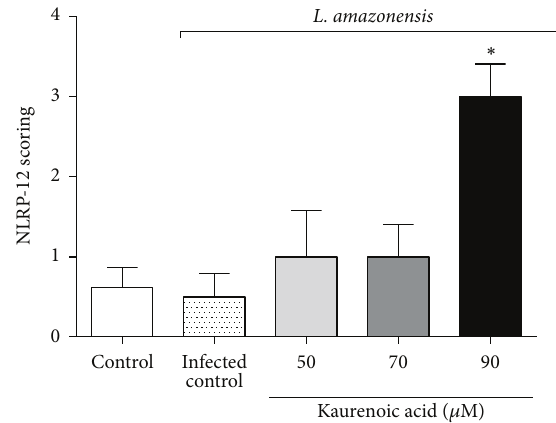
Figure 5: Kaurenoic acid upregulated the NLRP12 expression in macrophages infected with L. amazonensis . Immunocytochemistry scoring for NLRP12 in macrophages infected with L. amazonensis and treated with kaurenoic acid (50, 70, and 90 𝜇 M) for 24 h. Data represent the mean ± SEM of three independent experiments. ( ∗ Significantly different from infected cells ( 𝑃 < 0.05 ). (One-way ANOVA followed by Tukey’s